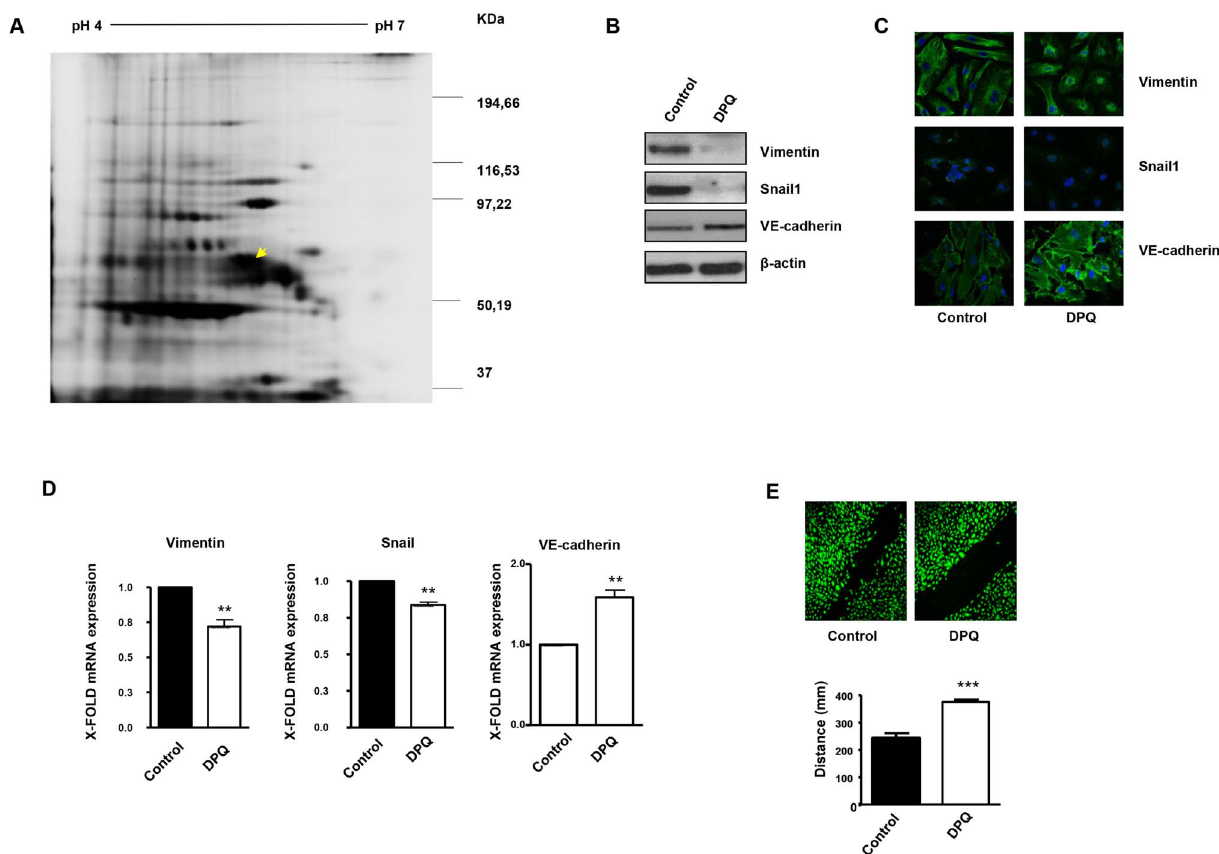
Figure 1. PARP inhibition down-regulates vimentin expression and inhibits endothelial-to-mesenchymal transition in HUVECs. Cell extracts from HUVEC either treated with vehicle or 40 m M DPQ were subjected to 2D electrophoresis as described in Materials and Methods. Image analysis software (DeCyder) indicated that seven proteins exhibited decreased expression in HUVEC treated with DPQ compared to untreated cells. Proteins were identified using MALDI-TOF. Spots labeled with arrows indicate proteins that were identified by mass spectrometry (see Figure 2). ( A ) The spot with the arrow is vimentin. ( B ) PARP inhibition reduced the expression of both vimentin and Snail1 and up-regulated VE-cadherin in human endothelial cells (HUVEC) as determined by immunoblotting, indirect immunofluorescence ( C ), and mRNA levels ( D ). PARP inhibition decreased HUVEC cell migration ( E ). (** P , 0.01, *** P , 0.001 PARP inhibitor groups versus DPQ).